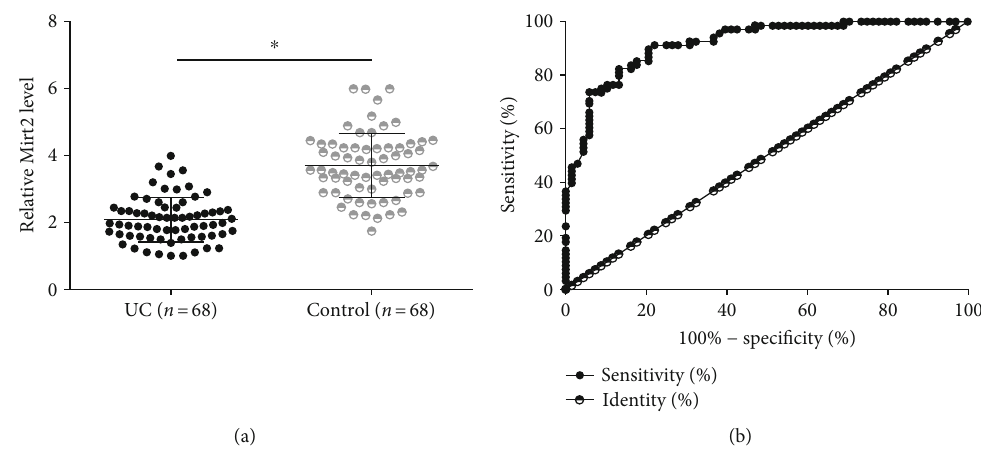
Figure 1: Plasma Mirt2 was downregulated in UC and showed diagnostic values. Mirt2 in plasma of the patient ( n = 68 ) and control ( n = 68 ) groups was detected by performing RT-qPCR, followed by data analysis using the unpaired t -test. Mirt2 levels in plasma were signi fi cantly lower in the patient group than in the control group (a), ( ∗ p < 0 : 05 ). ROC curve analysis showed that downregulation of Mirt2 in plasma of UC patients distinguished UC patients from healthy controls